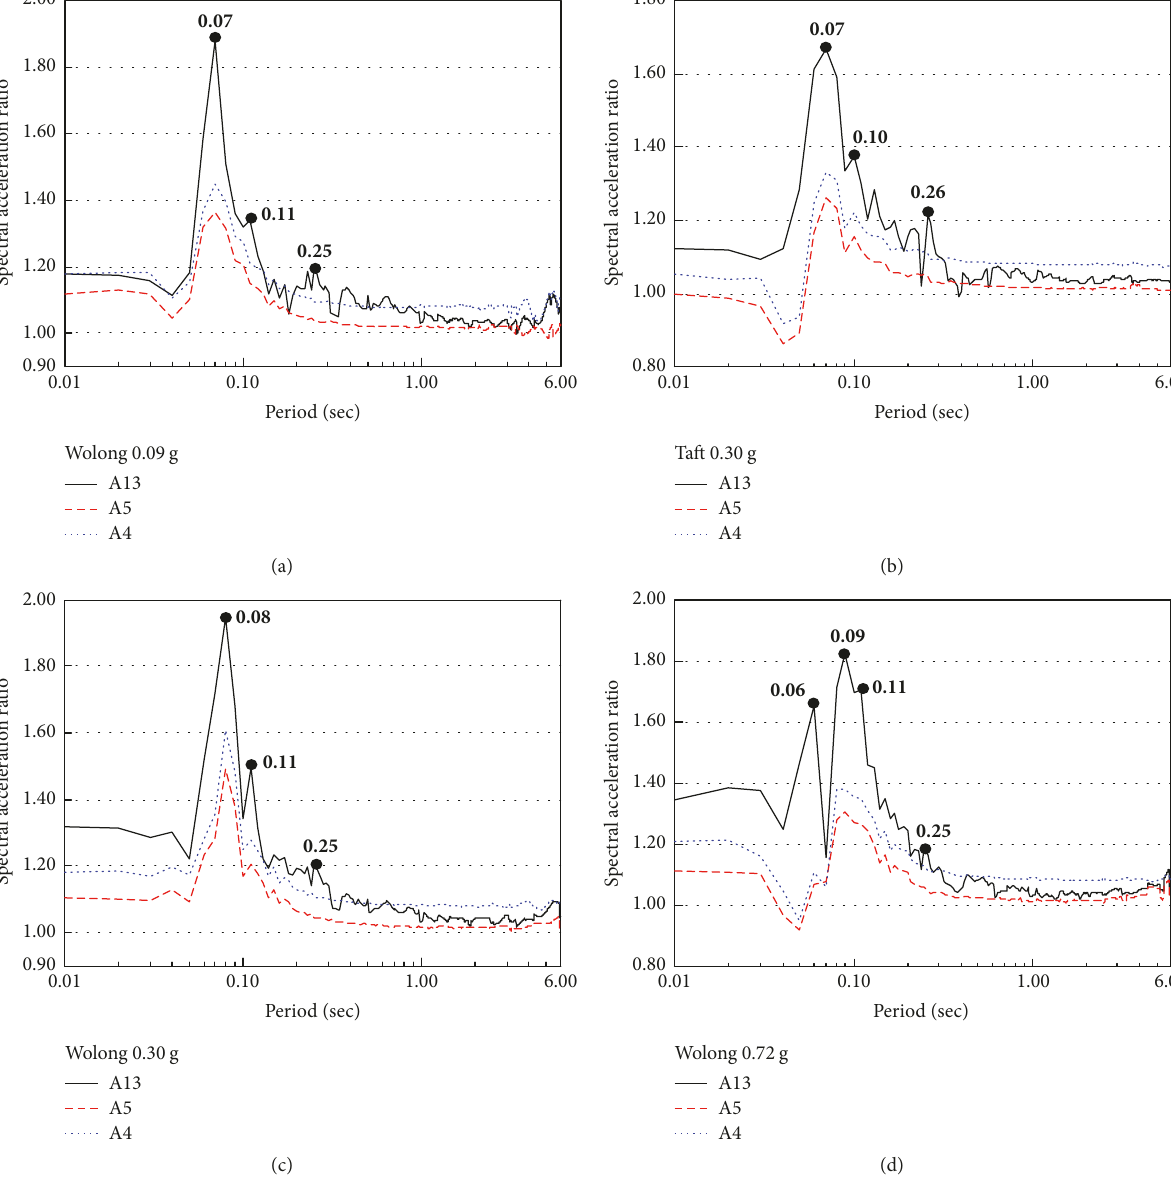
Figure 14: Spectral acceleration ratio of the structural responses under different input motions: (a) case 4, (b) case 12, (c) case 14, and (d) case